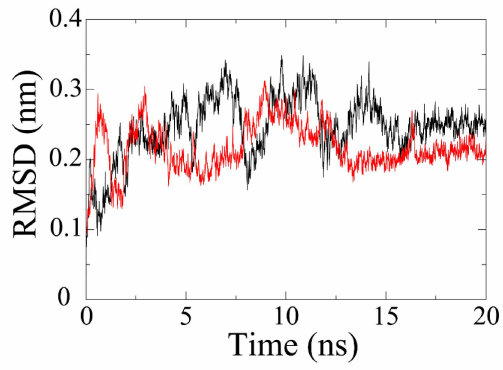
Figure 3. Backbone RMSD of PARP1 ® C inhibitor complexes. Black line denotes RMSD of the olaparib system while red line represents the PARP1-ZINC67913374 complex.